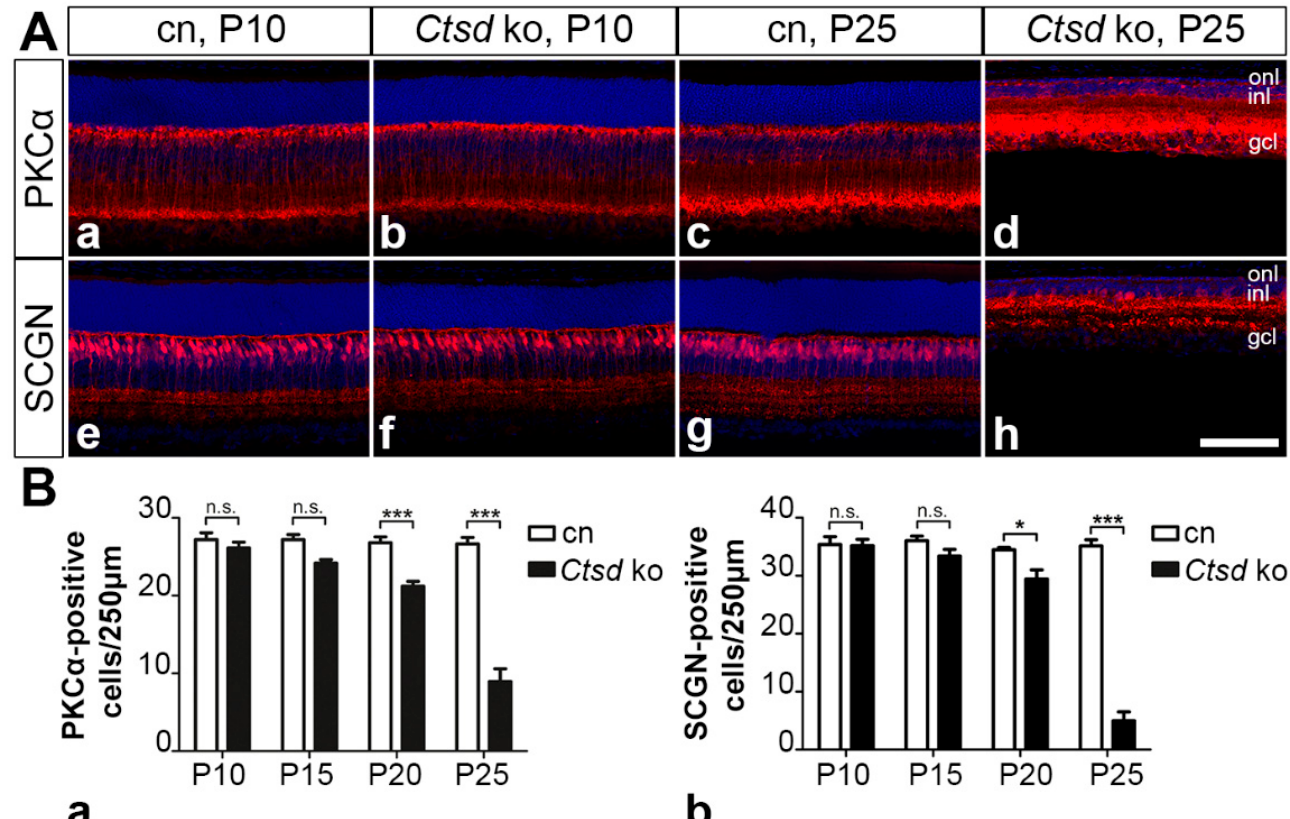
Figure 7. Degeneration of rod and cone bipolar cells. ( A ) The density of PKC α -positive rod bipolar cells and SCGN-positive cone bipolar cells in P10 Ctsd ko mice ( Ab , Af , respectively) was similar to that in age-matched control mice ( Aa , Ae , respectively). A pronounced loss of rod and cone bipolar cells was evident in 25-day-old mutant retinas ( Ad , Ah , respectively) when compared with control retinas ( Ac , Ag , respectively). ( B ) Quantitative analyses of mutant (filled bars) and control retinas (open bars) revealed a significant loss of rod ( Ba ) and cone bipolar cells ( Bb ) starting from P20. Each bar represents the mean value (±SEM) of 6 animals. n.s., not significant; *, p < 0.05; ***, p < 0.001, two-way ANOVA. cn, control; gcl, ganglion cell layer; inl, inner nuclear layer; ko, knock-out; onl, outer nuclear layer; P, postnatal day; PKC α , protein kinase C alpha; SCGN, secretagogin. Scale bar: 100 µm.